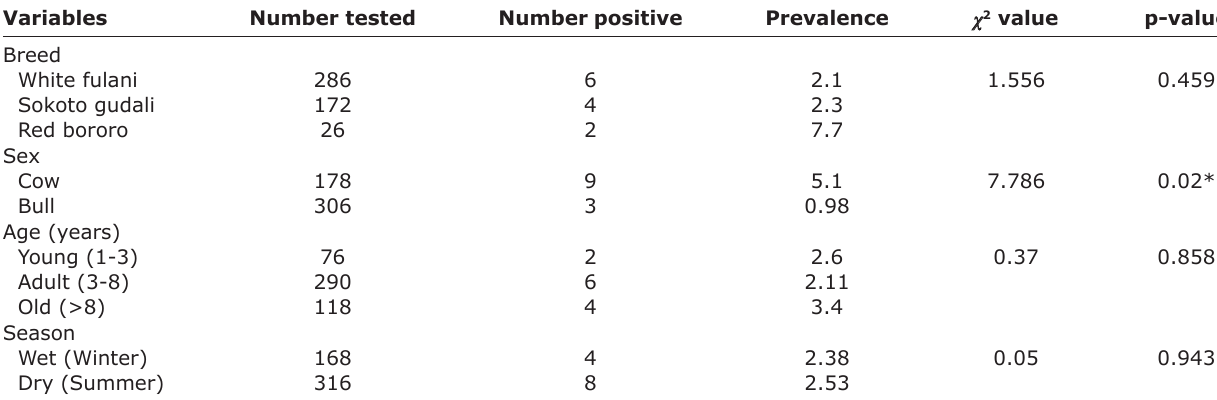
Table-2: Breed, sex, age and seasonal distribution of Brucella antibody in cattle (n=484) surveyed in Enugu State, Nigeria. Variables